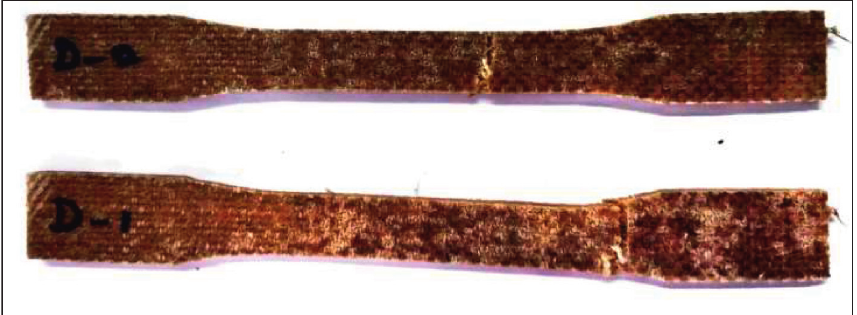
Figure 6: Tensile test